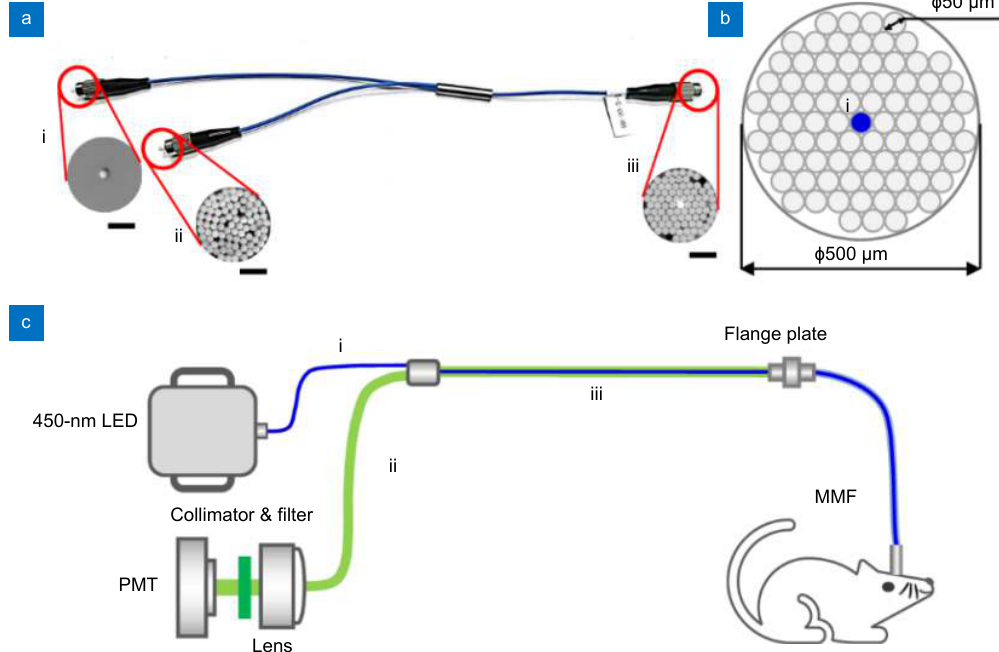
Fig. 1 | A custom-designed bifurcated fiber bundle and all-fiber-transmission single-channel fiber photometry system. ( a ) An image of the bifurcated fiber bundle. The bifurcated fiber bundle consists of 3 branches in total: the single-fiber branch i, the collection branch ii, and the common branch iii. The total length of this bundle is about 350 mm. The sub-image of iii was acquired using a high-intensity excitation light coupled into the single-fiber branch i. Scale bar, 200 μm. ( b ) Diagram of the bifurcated fiber bundle common branch iii. The common branch iii (500 μm) consists of 83 hexagon distributed optical fibers (Φ50 μm/0.54 NA) in total. The single fiber from branch i for excitation light (blue)